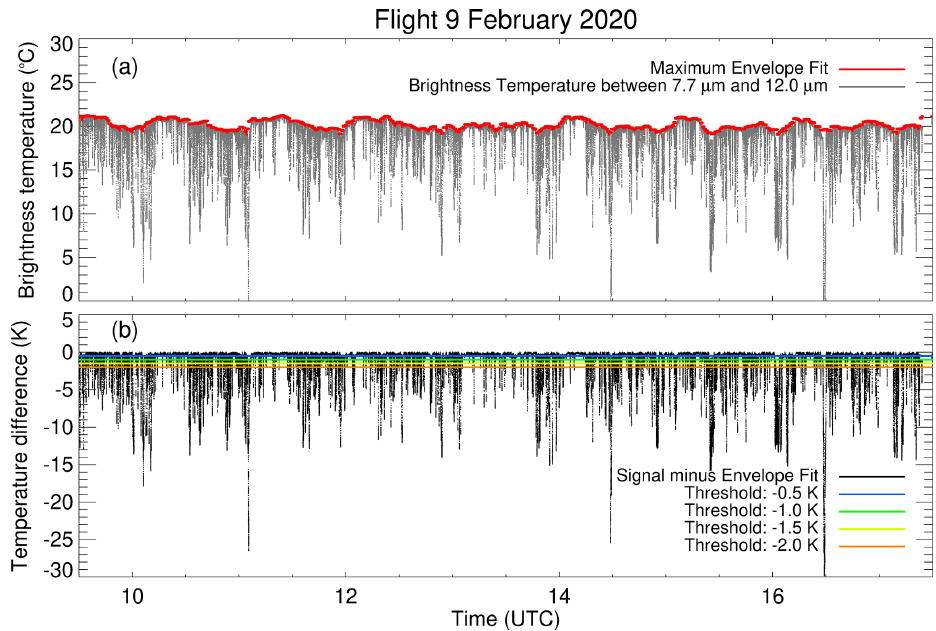
Figure 10. (a) Time series of brightness temperature (black) observed by the central 10 × 10 pixels of VELOX using channel 1 during the EUREC 4 A flight on 9 February 2020. The maximum envelope fit is illustrated by the red dots. (b) Difference between the measured VELOX brightness temperature and the maximum envelope fit (black). The four thresholds of 0.5, 1, 1.5, and 2.0K are included by colour-coded lines.